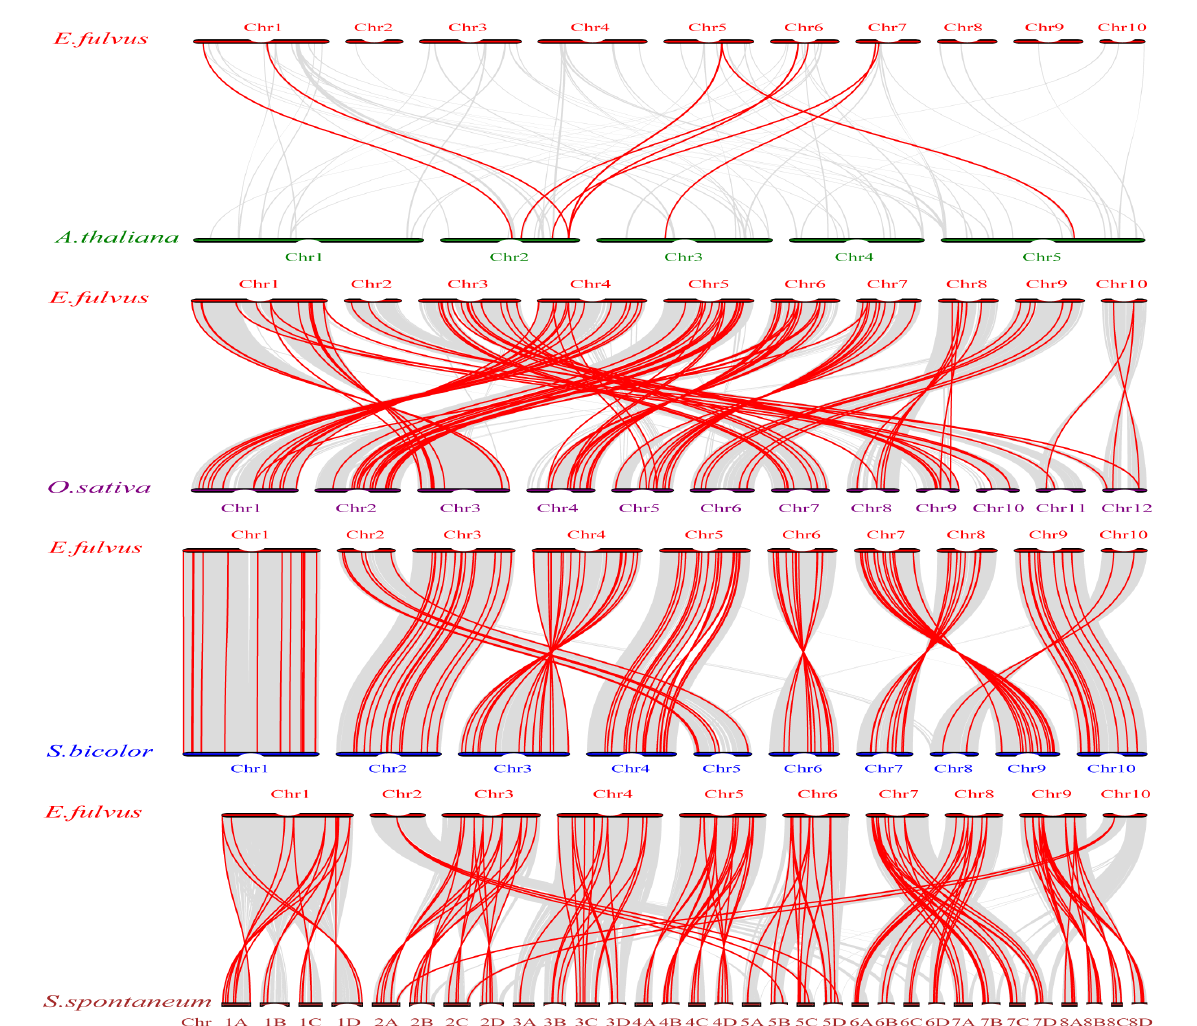
Figure 7. Synteny analysis of AP2/ERF genes among the representative plant species E. fulvus , A. thaliana , O. sativa , S. bicolour , and S. spontaneum . Grey lines in the background indicate the collinear regions within Erianthus fulvus and other plant genomes, while the red lines highlight the collinear AP2/ERF gene